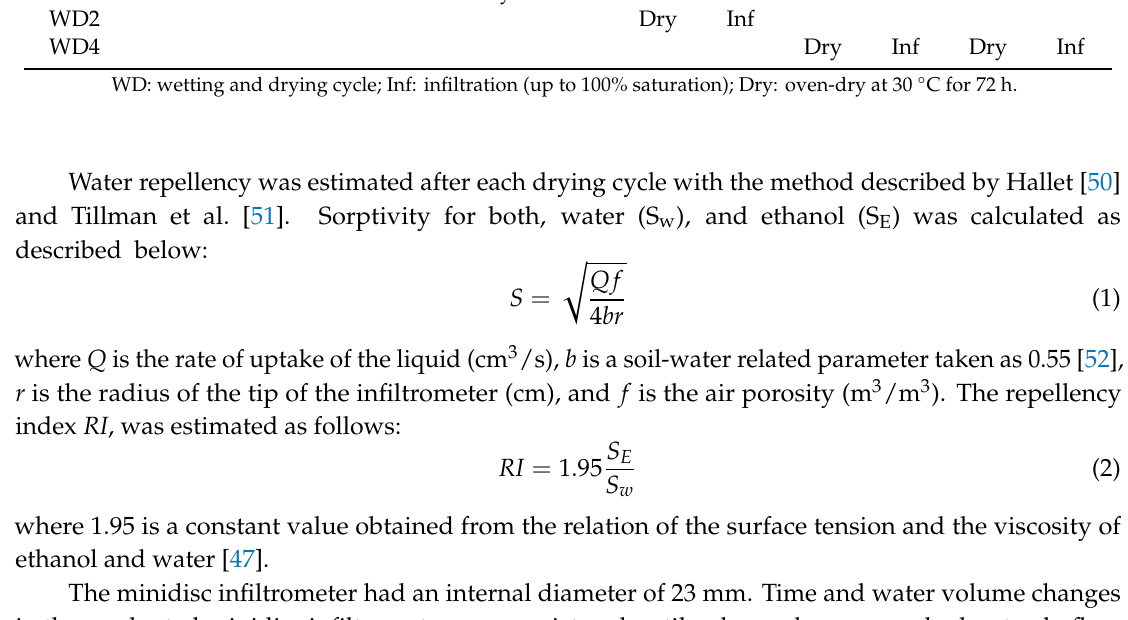
Table 1. Description of the sequence of WD cycles applied. WD cycles were executed sequentially. Cycle Description of the Sequence of the Cycle WD0 Sampling preparation Inf WD1 Dry Inf WD2 Dry Inf WD4 Dry